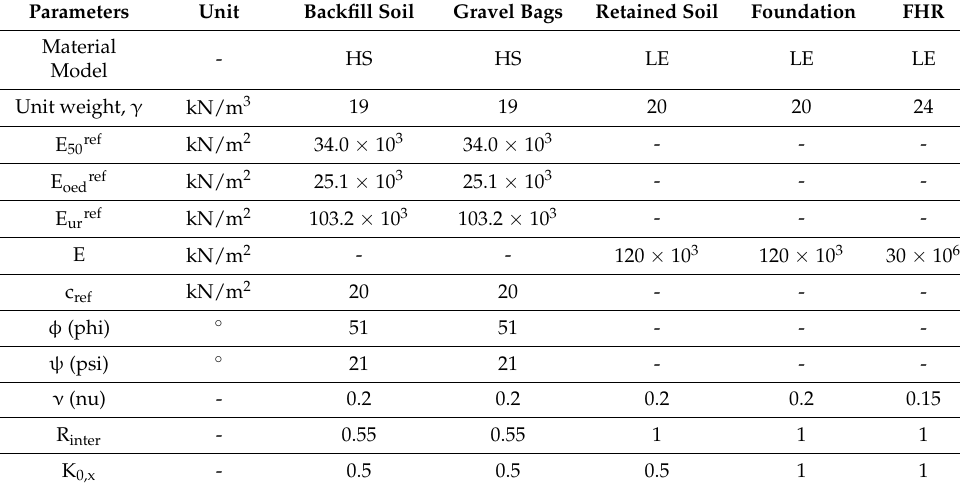
Table 1. Material Parameters for the Soil and FHR